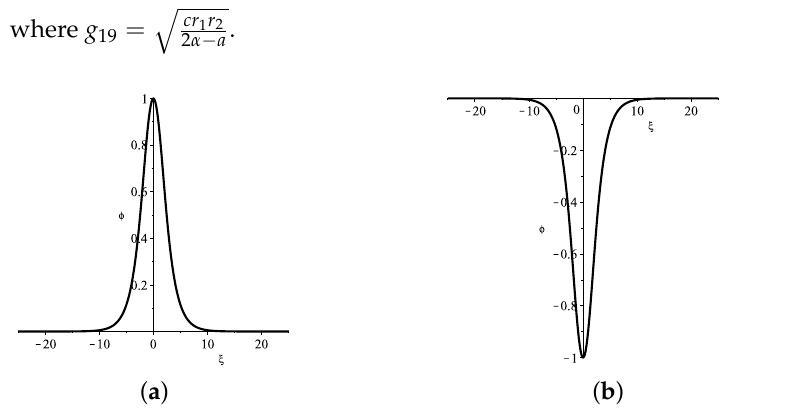
Figure 30. Solitary wave forms of system (5). ( a ) Bright solitary wave derived by (74) + . ( b ) Dark solitary wave derived by (74) −